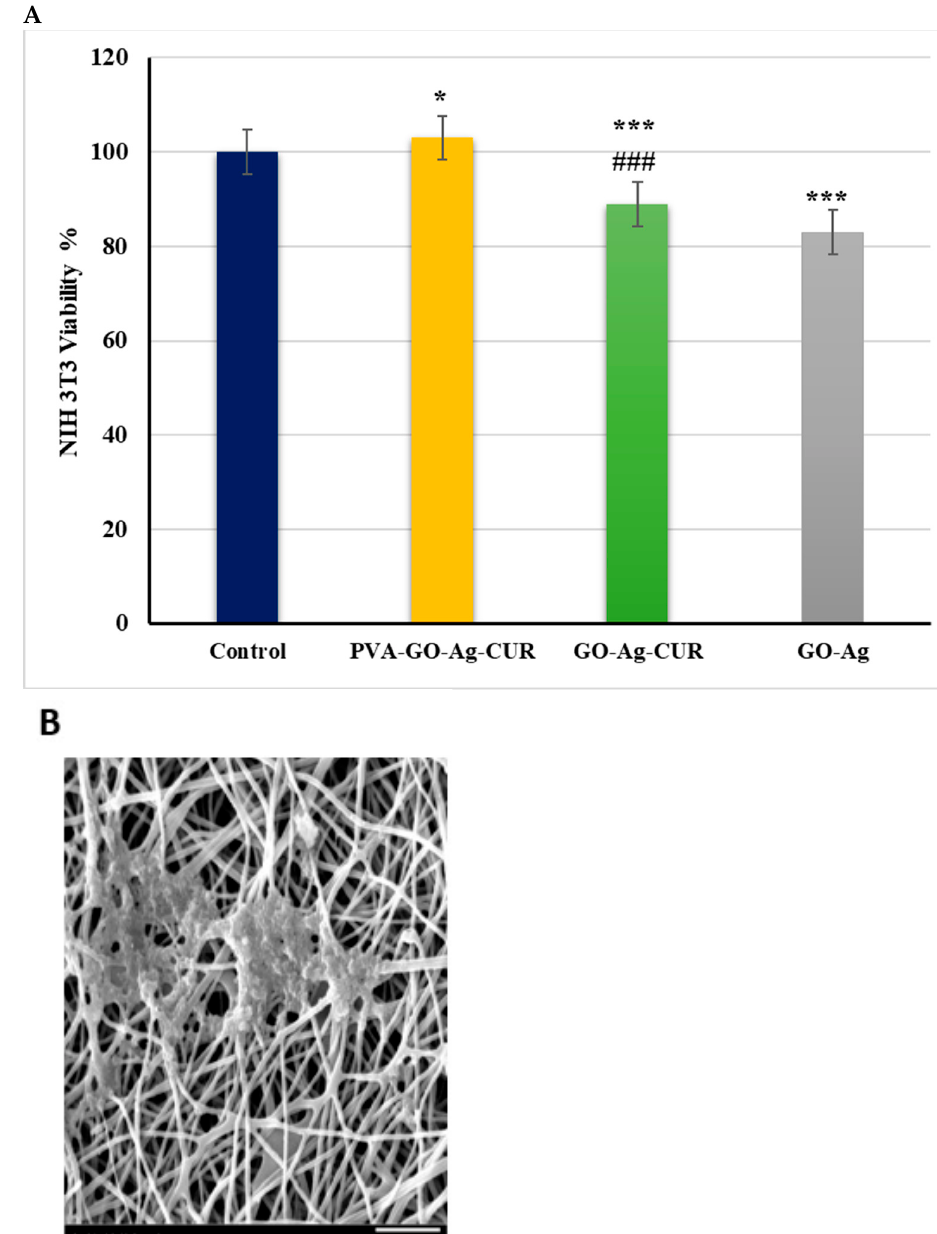
Figure 10. ( A ) The viability analysis of NIH 3T3 fibroblast cells treated with GO-Ag, GO-Ag-CUR, and PVA/GO-Ag-CUR groups after 24 h. Difference in viability between control and PVA-GO-Ag-CUR is significant with p < 0.005 (*). Difference between control and other groups is significant with p < 0.001 (***). Difference between PVA-GO-Ag-CUR and GO-AG-CUR is significant with p < 0.001 (###). ( B ) SEM image NIH 3T fibroblast cells cultured with PVA/GO-Ag-CUR nanofibers.